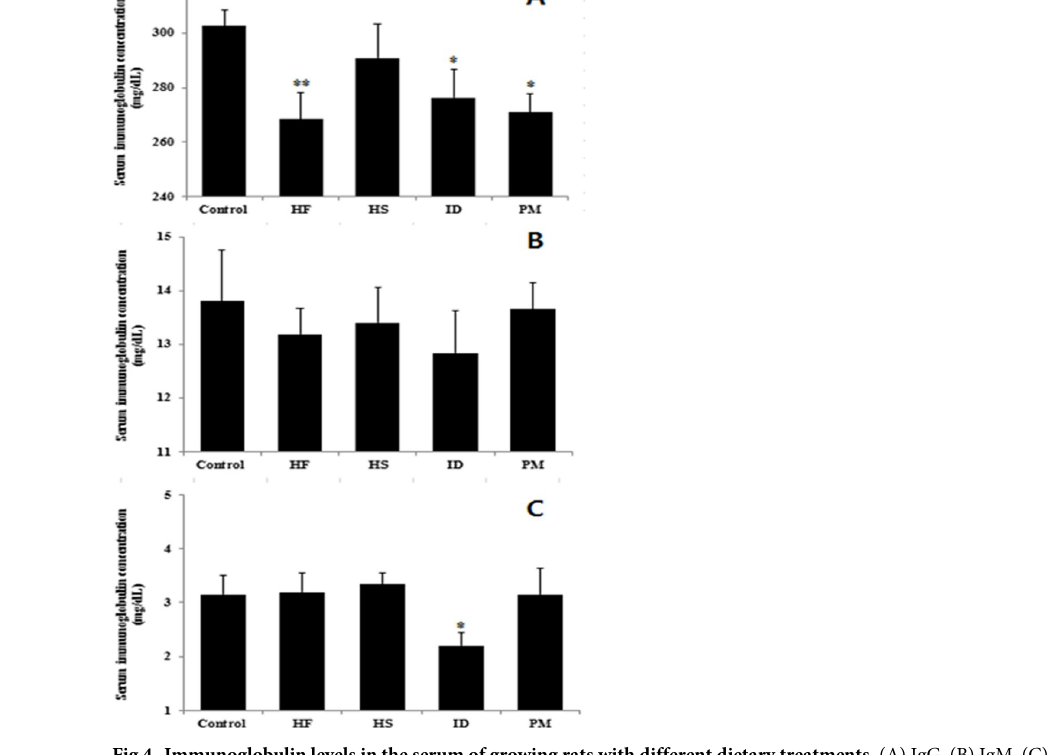
Fig 4. Immunoglobulin levels in the serum of growing rats with different dietary treatments. (A) IgG, (B) IgM, (C) IgA. HF, high fat; HS, high sucrose; ID, iron deficiency; PM, processed meat. Values are expressed as mean ± SEM. Statistical significance compared to control was accepted at � P < 0.05, �� P < 0.01.